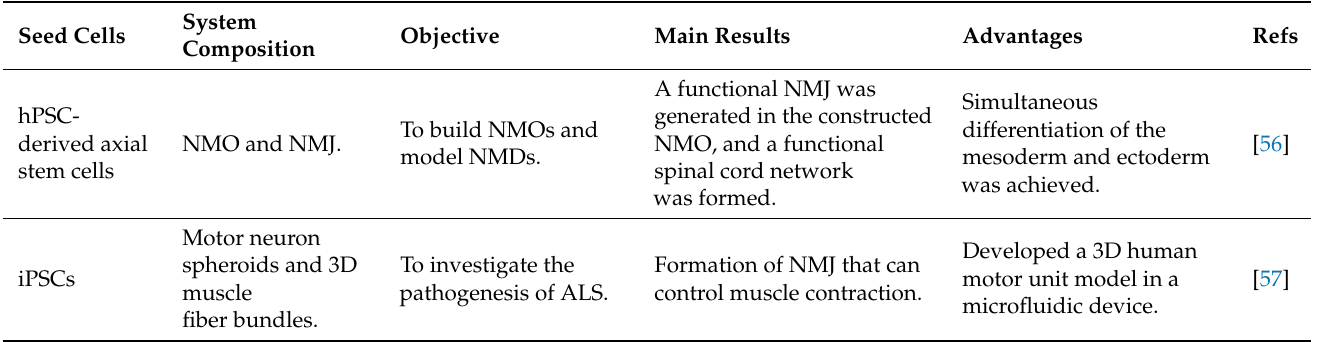
Table 3. Organoid-based co-culture